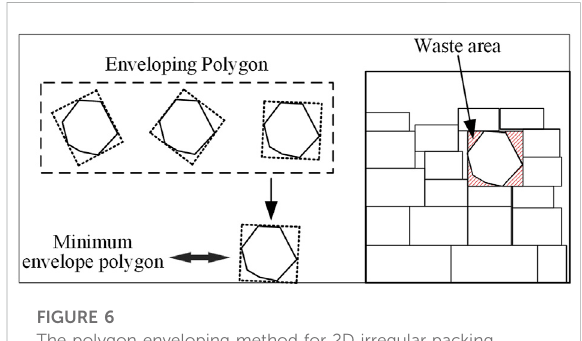
FIGURE 6 The polygon enveloping method for 2D irregular